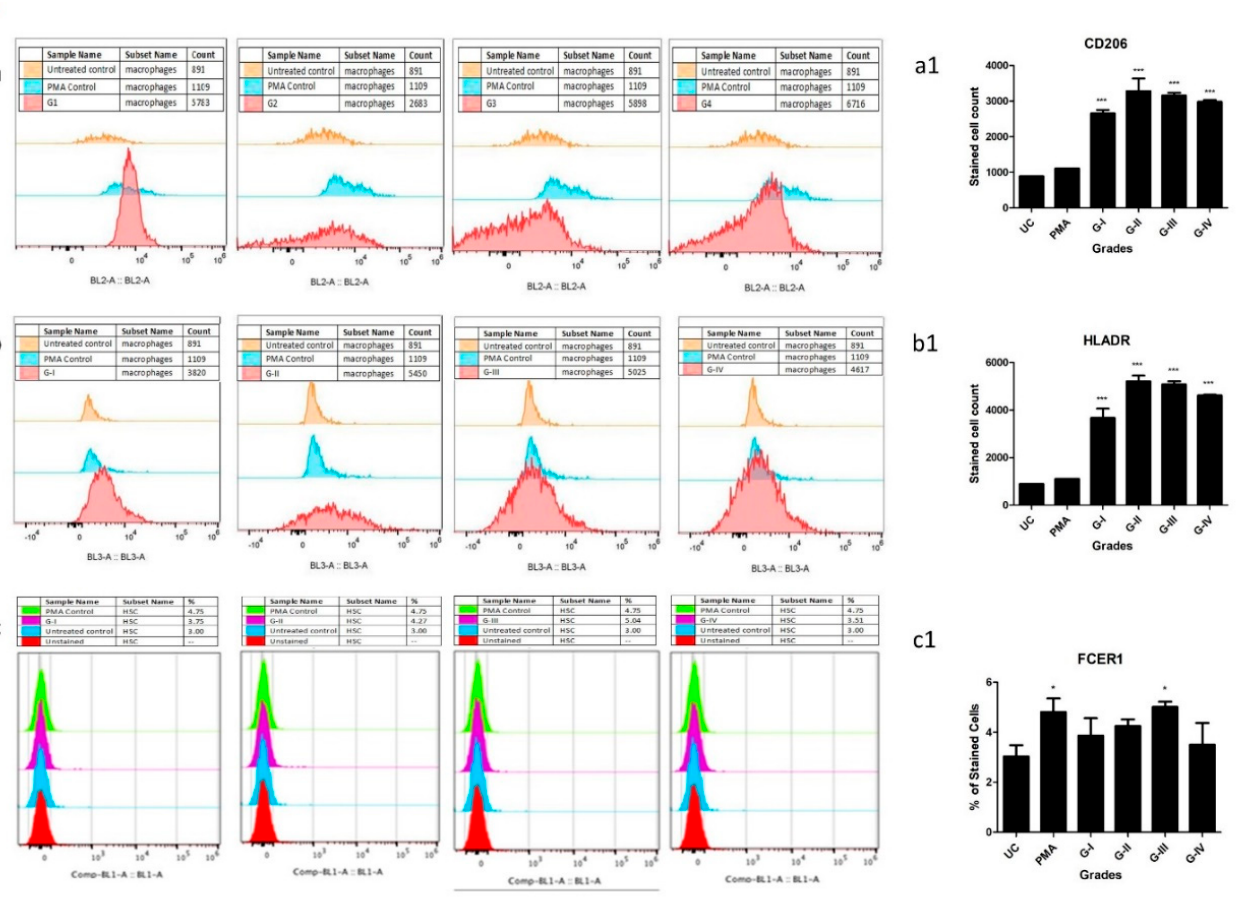
Figure 5. In vitro cell differentiation assay, where ThP1 and HSCs were treated with 10% (of culture medium) SF of KL grade I to IV for 9 days; expression of cell surface markers were analysed by flow cytometry on the 10th day. Shown are the representative overlaid histograms of the surface markers on ThP1 and HSCs. Bar graphs are the summary of the surface markers’ expression study, performed in triplicate. Sequence of ThP1 to macrophages differentiation analysed by ( a ) CD206, and ( b ) HLA-DR, ( a1 , b1 ) represent summary of CD206+ and HLADR+ expression values on ThP1 to macrophages differentiation sequence respectively; ( c ) sequence of HSCs to mast cells differentiation analysed by FCERI, ( c1 ) represent summary of FCERI+ expression values on HSCs to mast cell differentiation sequence; * p < 0.05, *** p < 0.001 compared to UC.